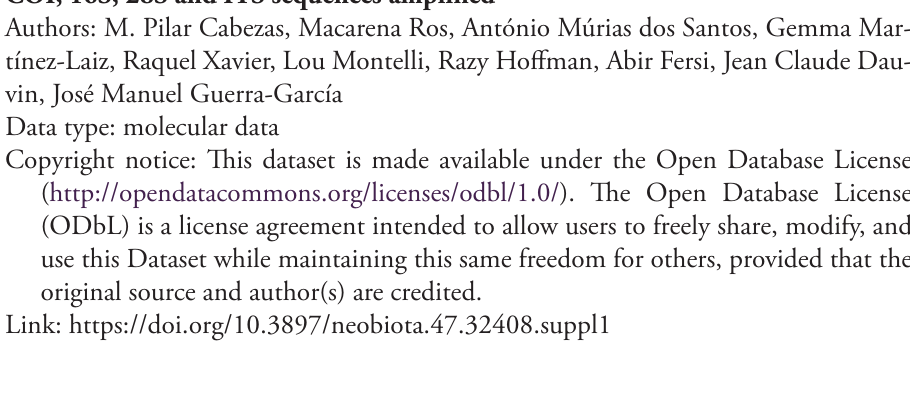
Table S1. Individual code, specimen voucher, and GenBank accession numbers of COI, 16S, 28S and ITS sequences amplified